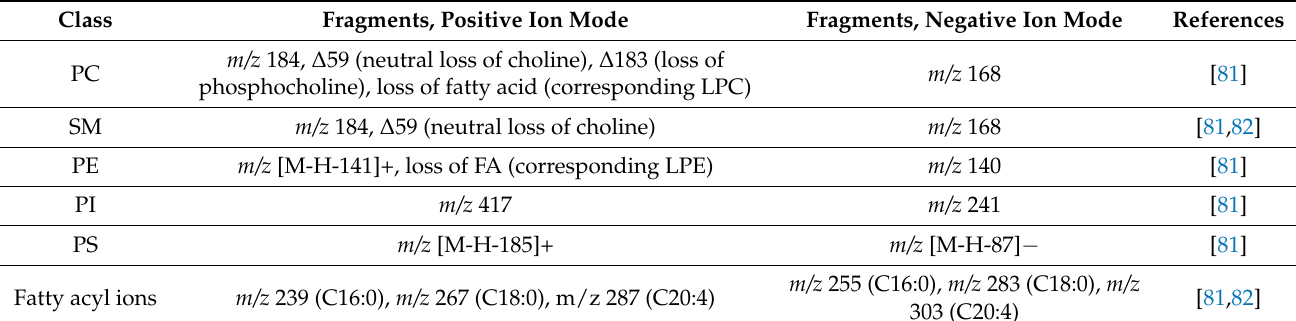
Table 1. Fragments of phospholipids that can be identified in MALDI spectra by applying collision induced decay (CID). The fragments that are characteristic for an individual PL class are